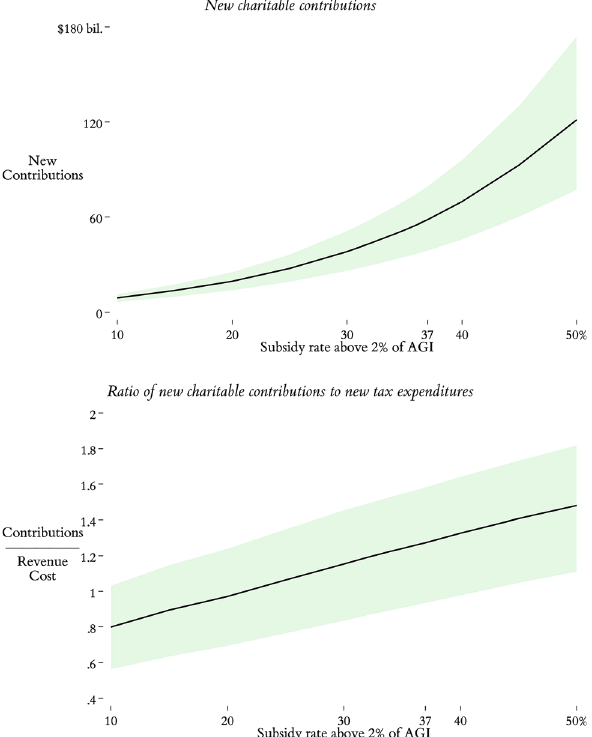
Figure 2: Outcomes of alternative subsidy rates on giving over 2% of AGI. Notes: Black lines mark simulations under baseline assumption of taxpayer sensitivity to tax incentives. Green shading marks the range between alternative high- and low-sensitivity conditions. Simulations assume a nonrefundable credit for charitable donations of 10% on gifts up to 2% of adjusted gross